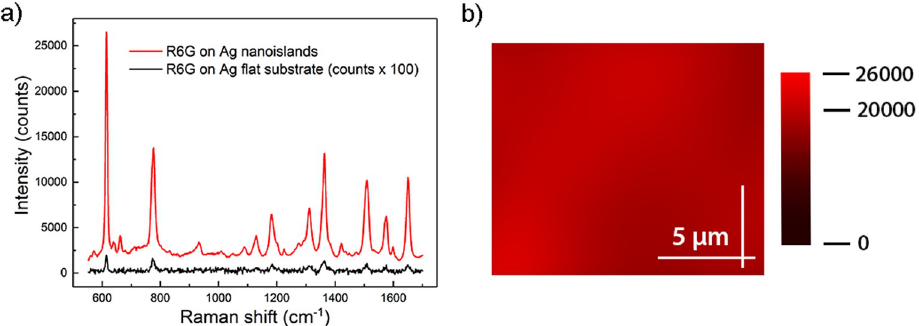
Fig 2. SERS efficiency of the fabricated Ag nanostructured surfaces. (a) SERS spectra of R6G at 1 μ M concentration on the Ag nanostructured substrate (red line) and on the Ag flat substrate (black line). (b) 2D SERS mappingcenteredat the R6G bandat 615 cm -1 . The measurements were done with 532 nm laser line, 100 μ W power and 10 second acquisitiontime.